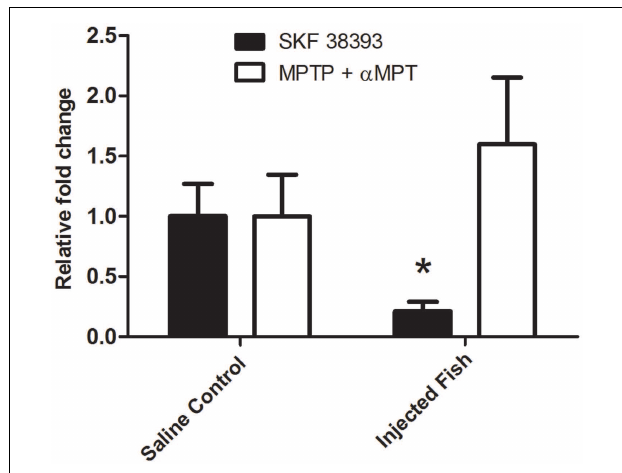
FIGURE 3 | Real-time RT-PCR of aromatase B mRNA levels in the hypothalamus of SKF 38393-injected fish after 5h or MPTP + α MPT-injected fish after 24h. SKF 38393 data were normalized to β -actin and MPTP + α MPT data were normalized to 18S as they were determined to be the most stable for the respective experiments. A Mann–Whitney U Rank Sum test was performed on injected vs. control fish with significance (*) considered at p < 0.05